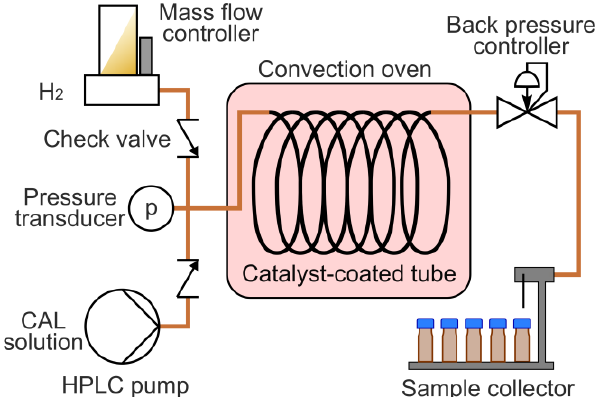
Figure 16. The scheme of the continuous flow hydrogenation system.